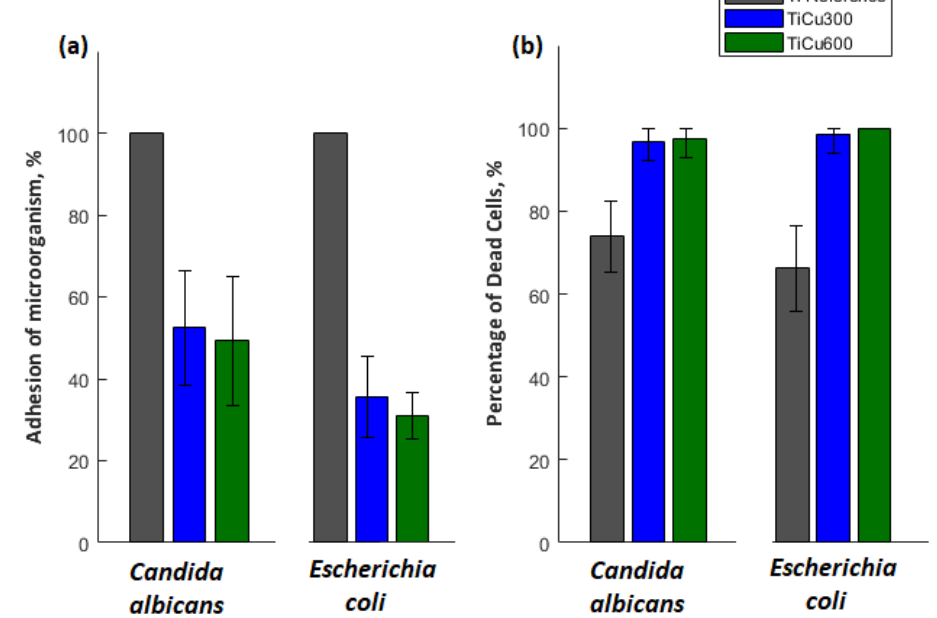
Figure 11. Quantitative analysis of microorganism adhesion to the coatings ( a ) and percentage of dead cells ( b ).